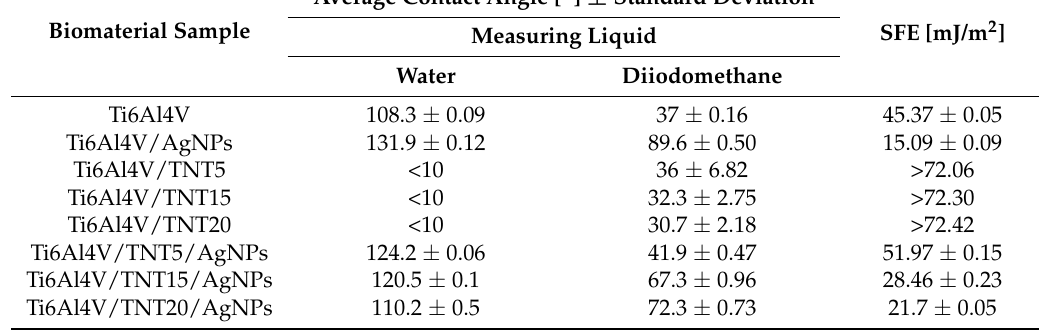
Table 4. The results of the contact angle measurement, which was made three times using distilled water and diiodomethane and the results of the surface free energy (SFE) of biomaterials used in Owens-Wendt